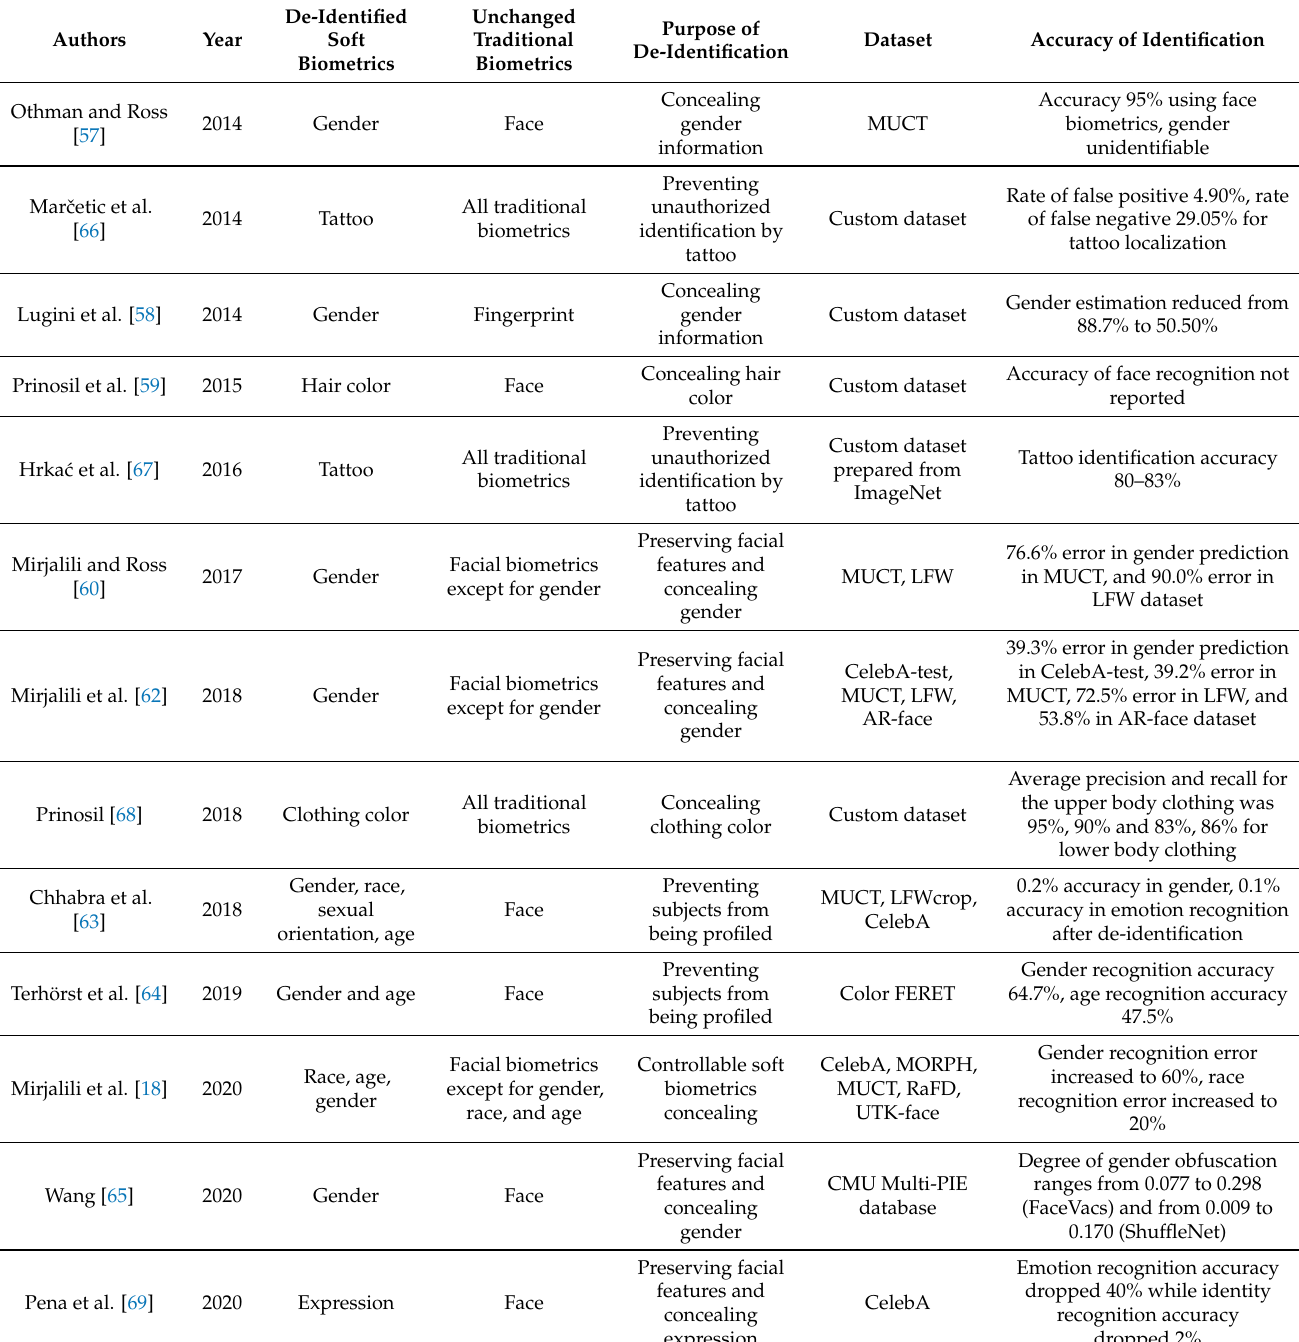
Table 4. Summary of traditional biometric preserving de-identification